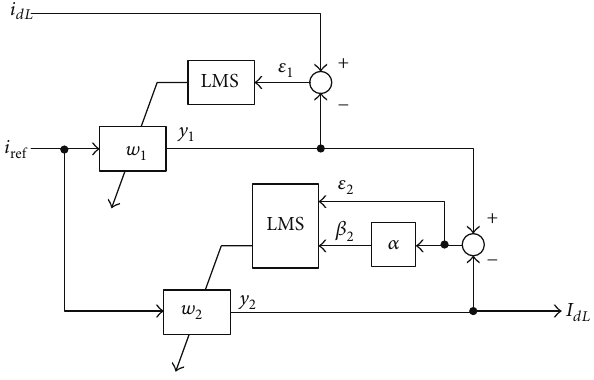
Figure 5: Block diagram of novel adaptive filter.